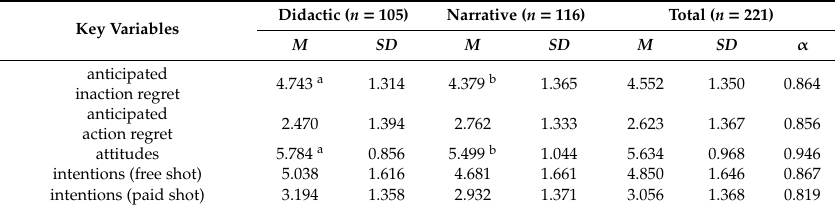
Table 1. Means, standard deviations, and reliabilities for key